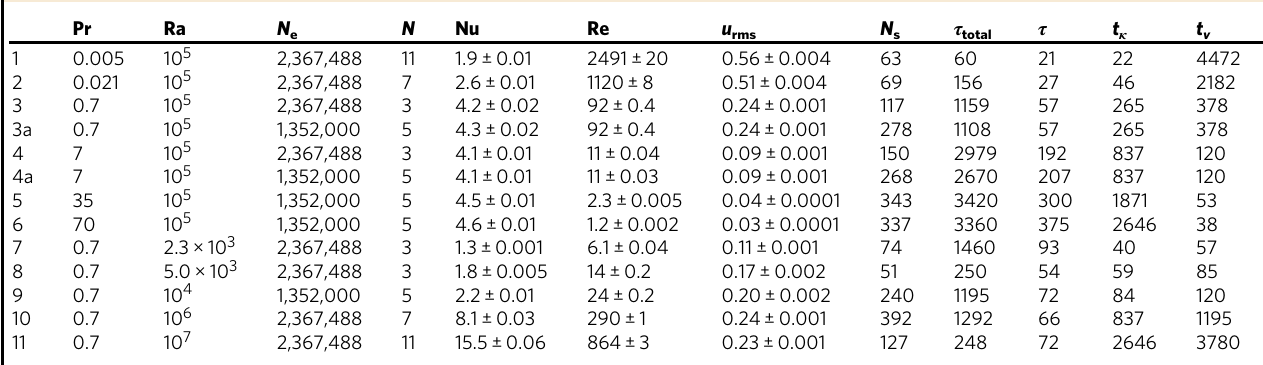
Table 1 Parameters of the different spectral element simulations